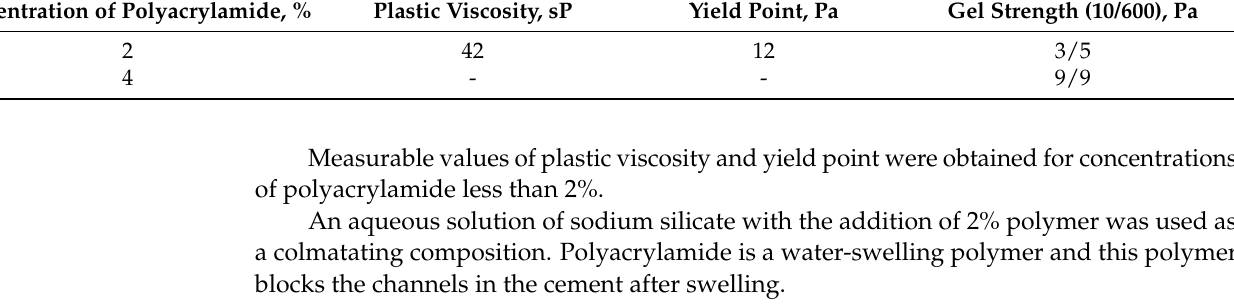
Table 3. Rheological characteristics of aqueous solution of sodium silicate and polyacrylamide. Concentration of Polyacrylamide,